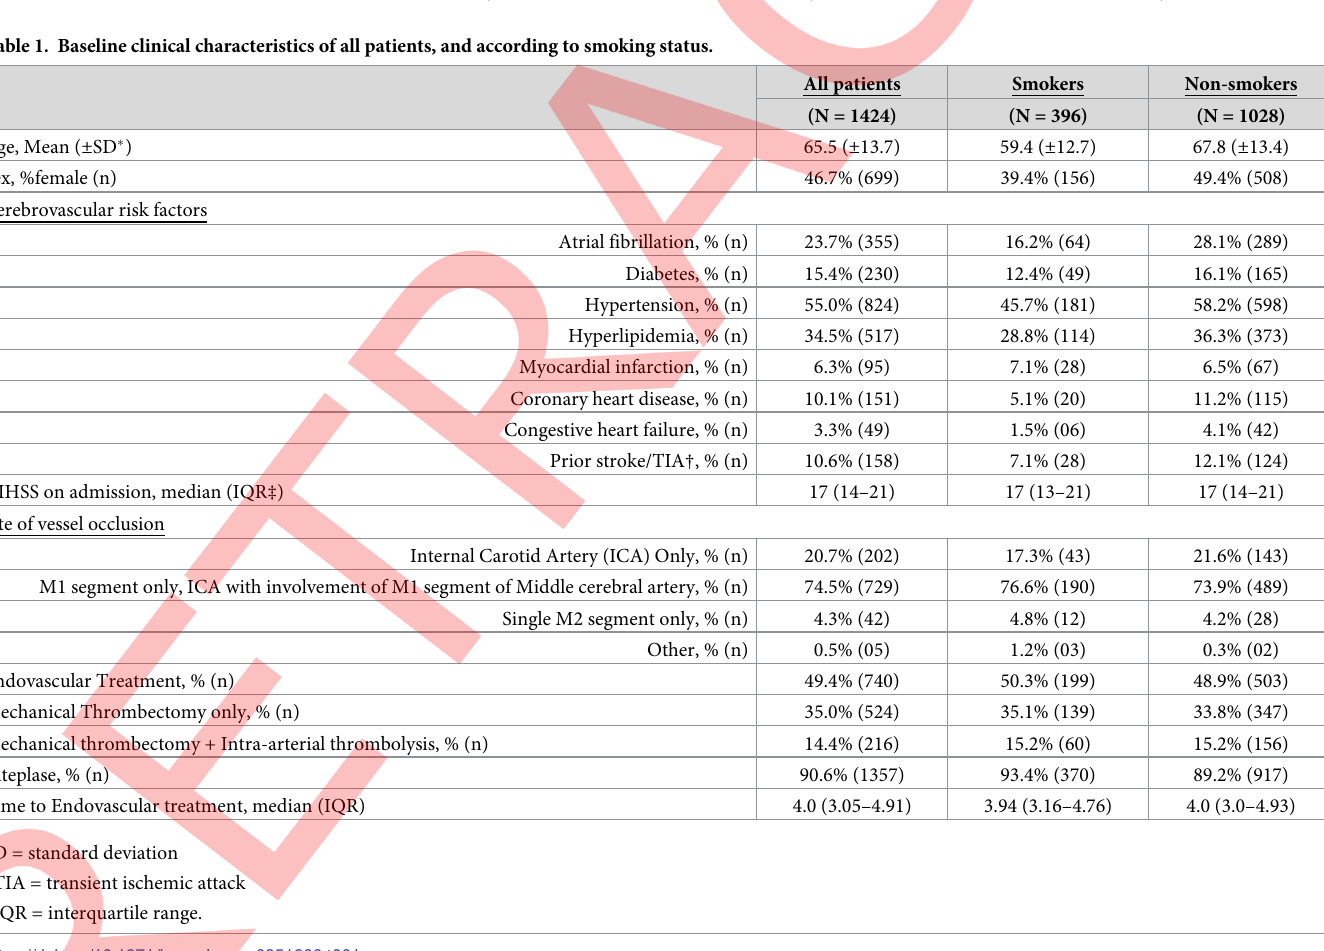
Table 1. Baseline clinical characteristics of all patients, and according to smoking status.